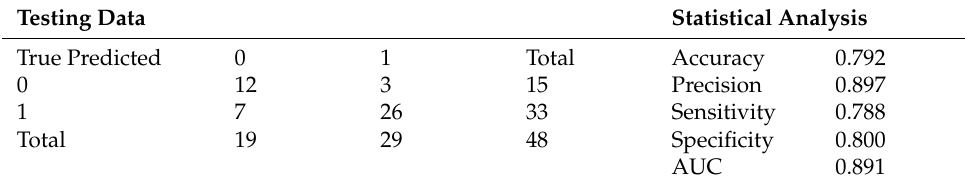
Table 3. Confusion matrix for the “24-H” Model.